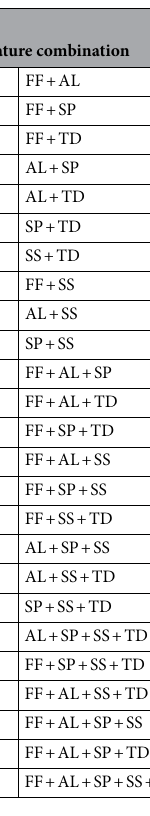
Table 4. Feature extraction of fake-video uploaders and classification results.